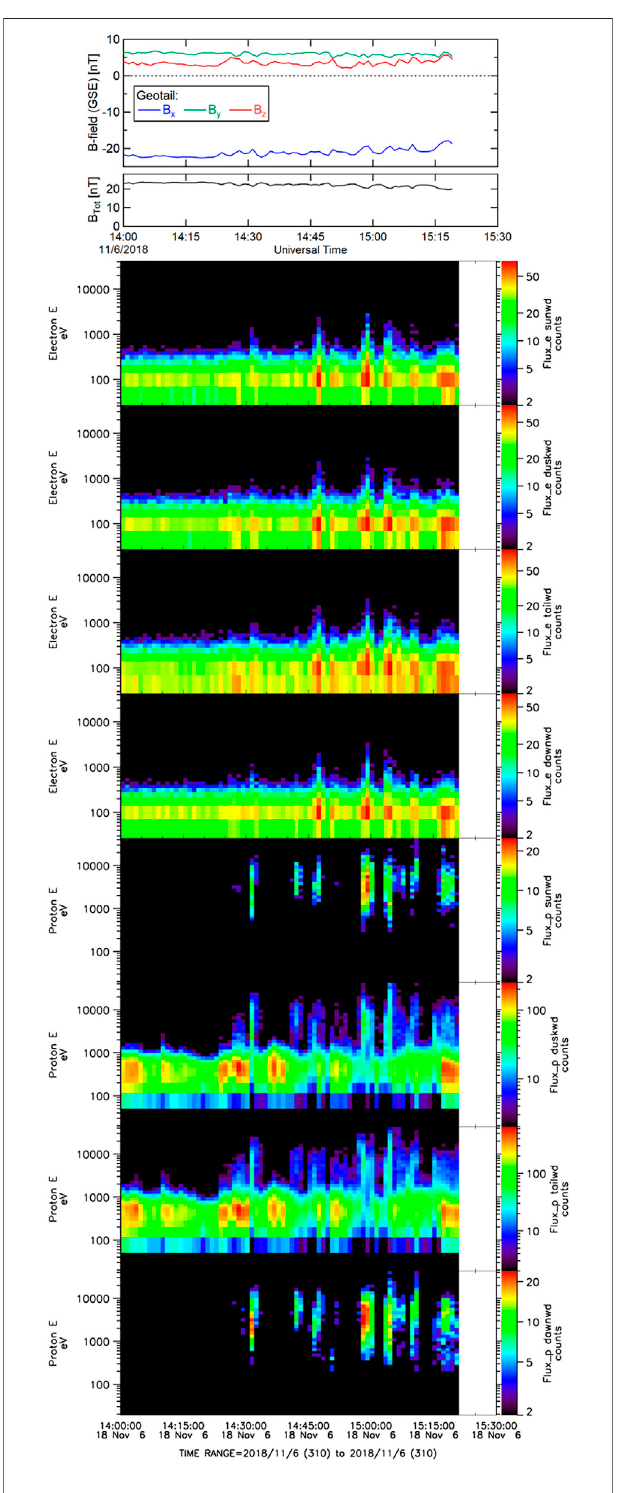
FIGURE 9 | Expanded view of the Geotail magnetic fi eld and electron and proton energy fl ux spectrograms. Layout is the same as Figure 8 .